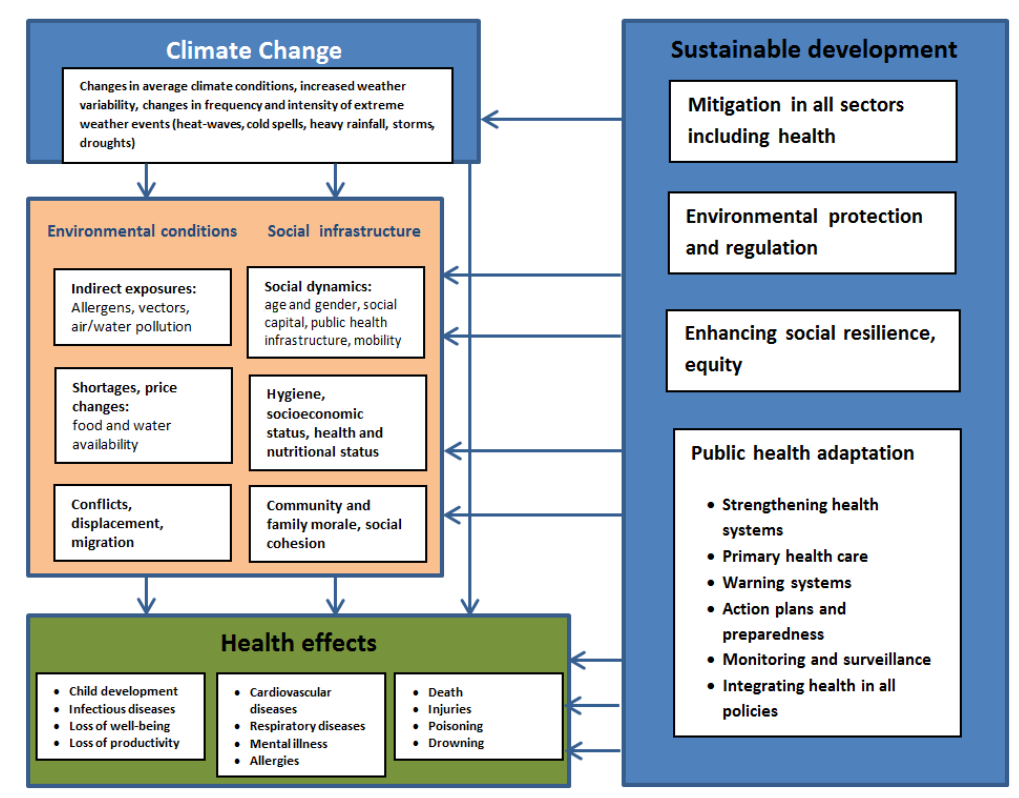
Figure 1. Pathways of climate change, sustainable development and health. Source: